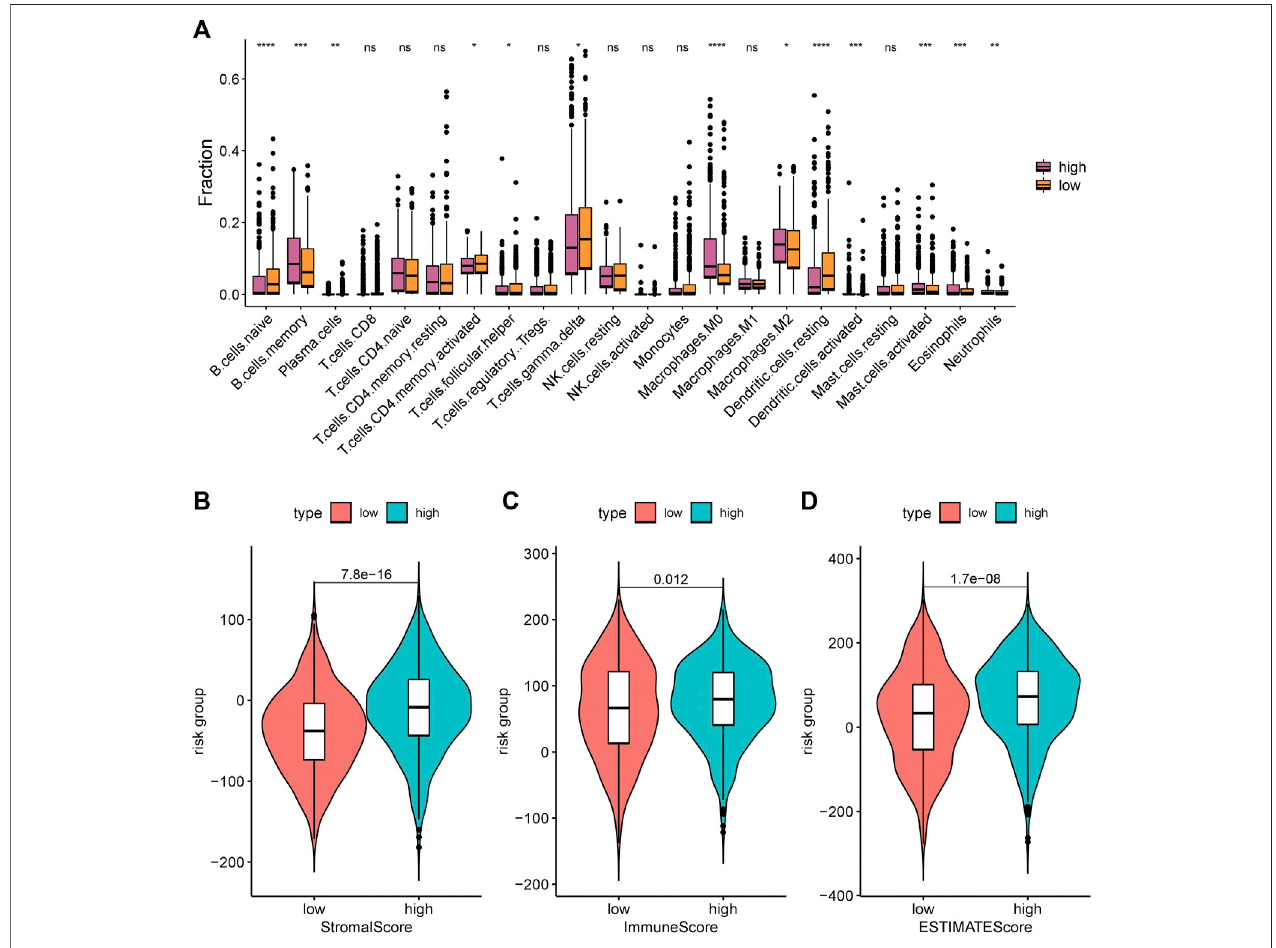
FIGURE 8 | Immune in fi ltration levels of 22 immune cell types in the low-risk group and high-risk group. (A) CIBERSORT algorithm was used to assess the difference in immune in fi ltration: *, p < 0.05; **, p < 0.001; ***, p < 0.01; ****, p < 0.001; ns, p > 0.05 (nonsigni fi cant). (B) Stromal score; (C) Immune score; and (D) ESTIMATE